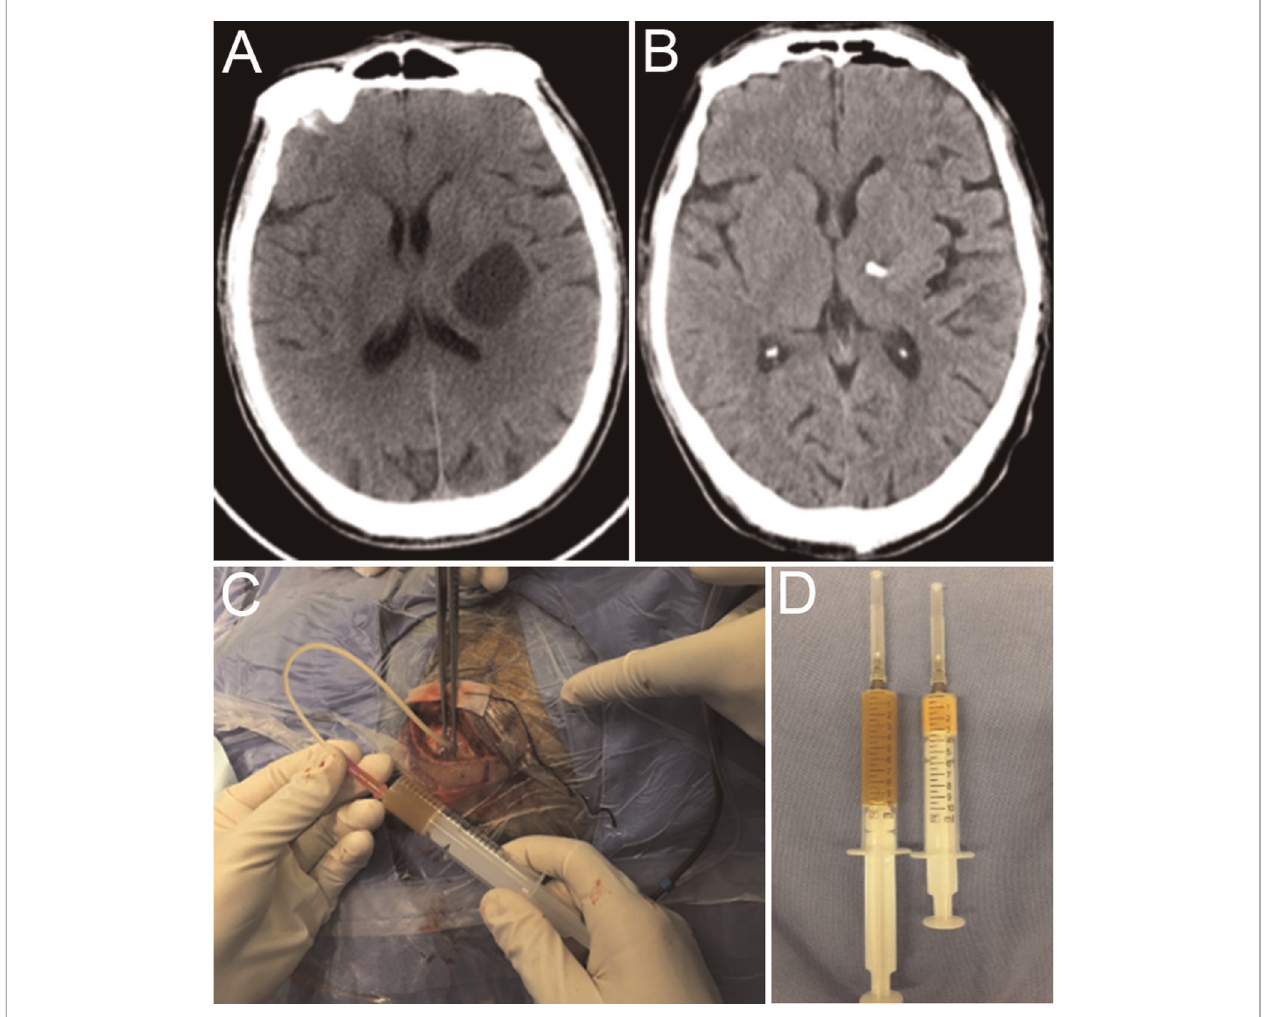
FIGURE 2 | Preoperative CT reexamination ( A ), postoperative CT ( B ), intraoperative cystic fl uid aspiration ( C ), and intraoperative specimen ( D